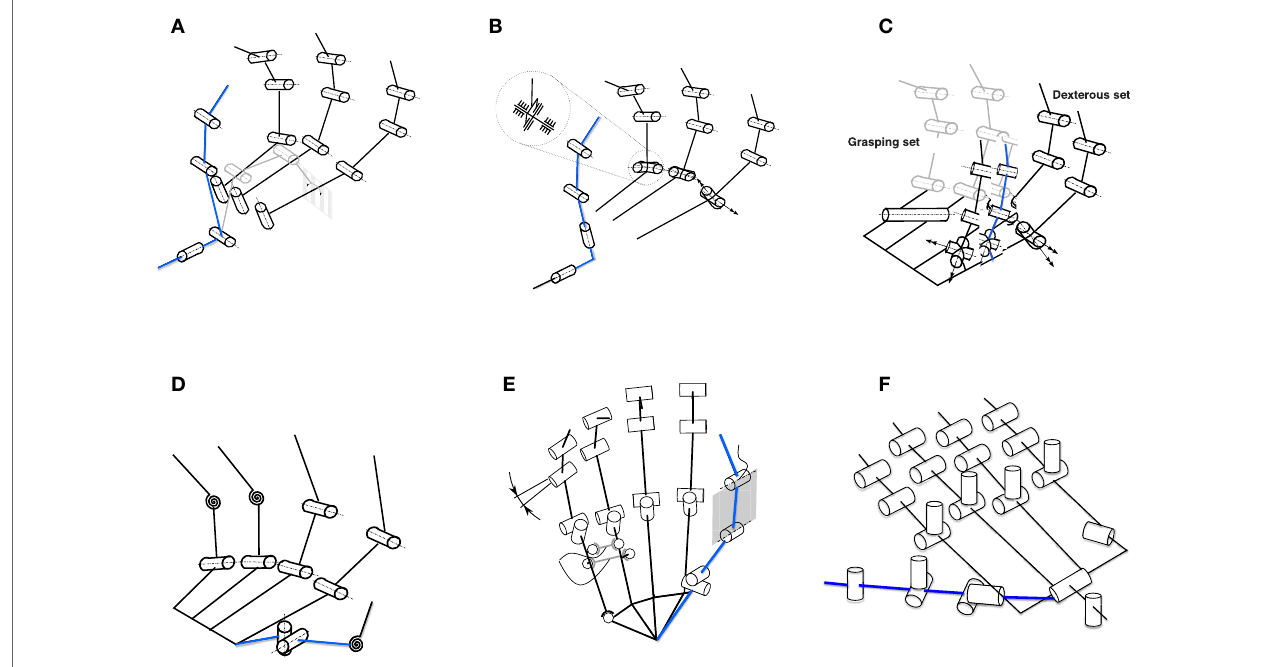
FiGURe 2 | Biomimetic thumb designs (highlighted in blue) in some selected robotic hands. The kinematic models are reprinted and highlighted with kind permission from Grebenstein (Grebenstein, 2012) and Walker (Greenhill et al., 2010). (A) Utah/MIT hand (Jacobsen et al., 1986)—two thumb proximal joint axes are separated and thumb base is placed on the palm between first and second fingers with its proximal axis parallel to the palm plane to reduce tendon routing complexity. (B) Twenty-one hand (Iwata and Sugano, 2009)—similar to the Utah/MIT hand, the two thumb proximal joint axes are separated. However, the second axis is designed to avoid thumb singulairty. (C) Robonaut hand (Lovchik and Diftler, 1999)—thumb has same finger kinematic structure and is not positioned directly opposed to the fingers. Thumb base yaw is 70° and pitch is 110° to increase its ROM. (D) ARMAR hand (Fukaya et al., 2000)—thumb has only 1-DOF with its rotational axis set at an angle of 6.5° to the vertical line. AA axis is positioned proximal to the palm to avoid singularity. (e) Awiwi hand (Grebenstein, 2012)—thumb has four DOFs to agree with the DLR hand arm system. Inclinations are introduced in the IP and MCP joints to improve opposition and power grasp. Thumb TM joint axes are orthogonal but not intersecting. (F) Shadow hand (Greenhill et al., 2010)—24-DOF shadow hand has a five-DOF thumb fully actuated using air muscles or smart motors. Thumb is positioned on the front of the palm with its A-A axis inclined with respect to the index finger (Grebenstein, 2012).